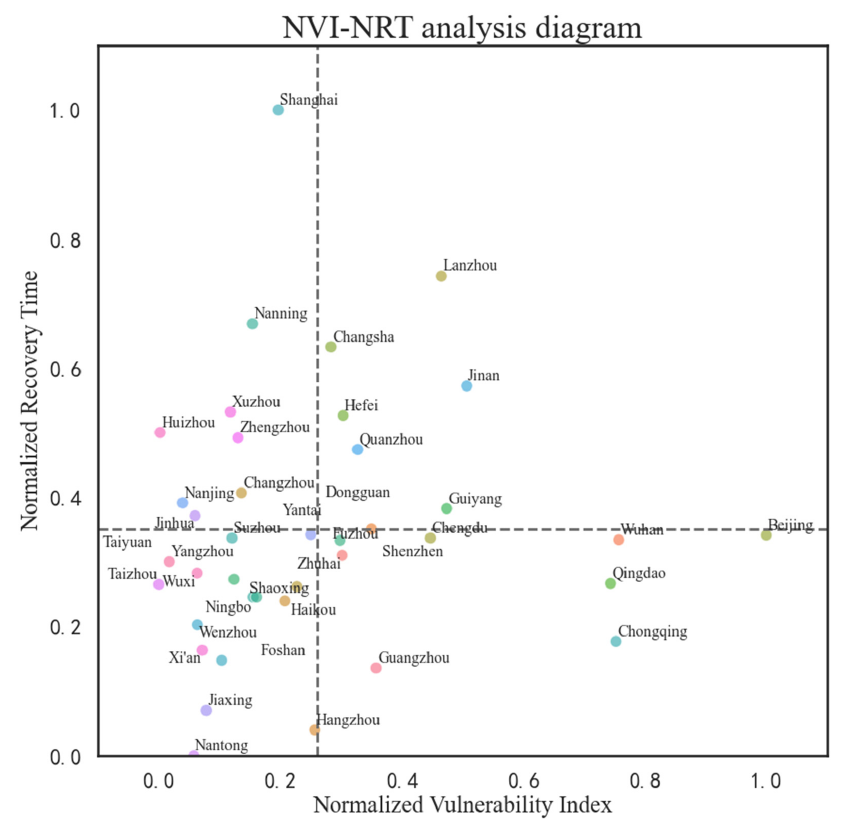
Figure 4. The diagram of comprehensive traffic evaluation results.